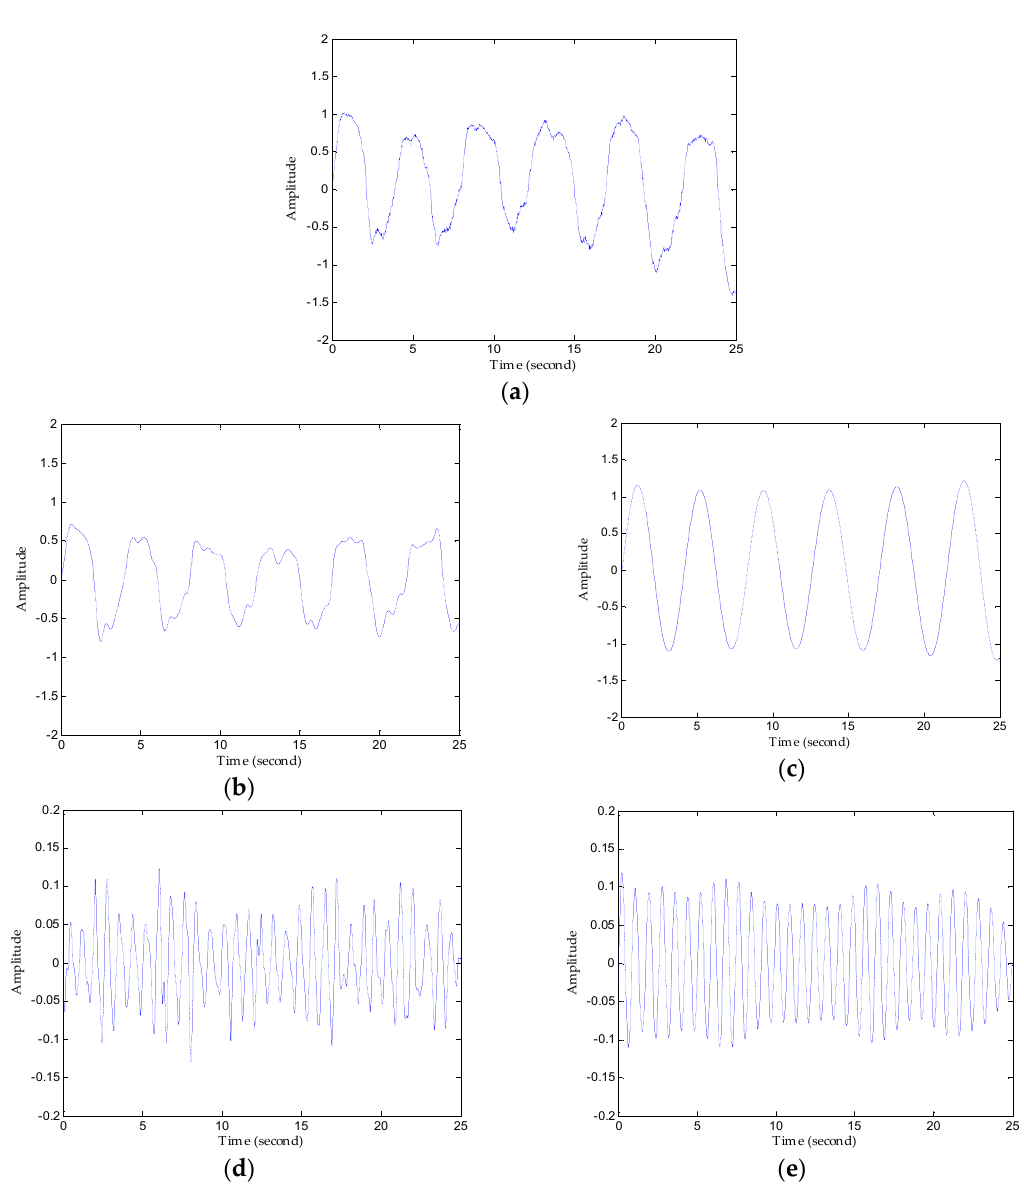
Figure 10. Comparison of results using the FIR filter and the proposed method. ( a ) The original waveforms obtained after clutter suppression; ( b ) respiration waveforms obtained via the FIR band-pass filter; ( c ) respiration waveforms obtained via the proposed method; ( d ) heartbeat waveforms obtained via the FIR band-pass filter; ( e ) heartbeat waveforms obtained via the proposed method.